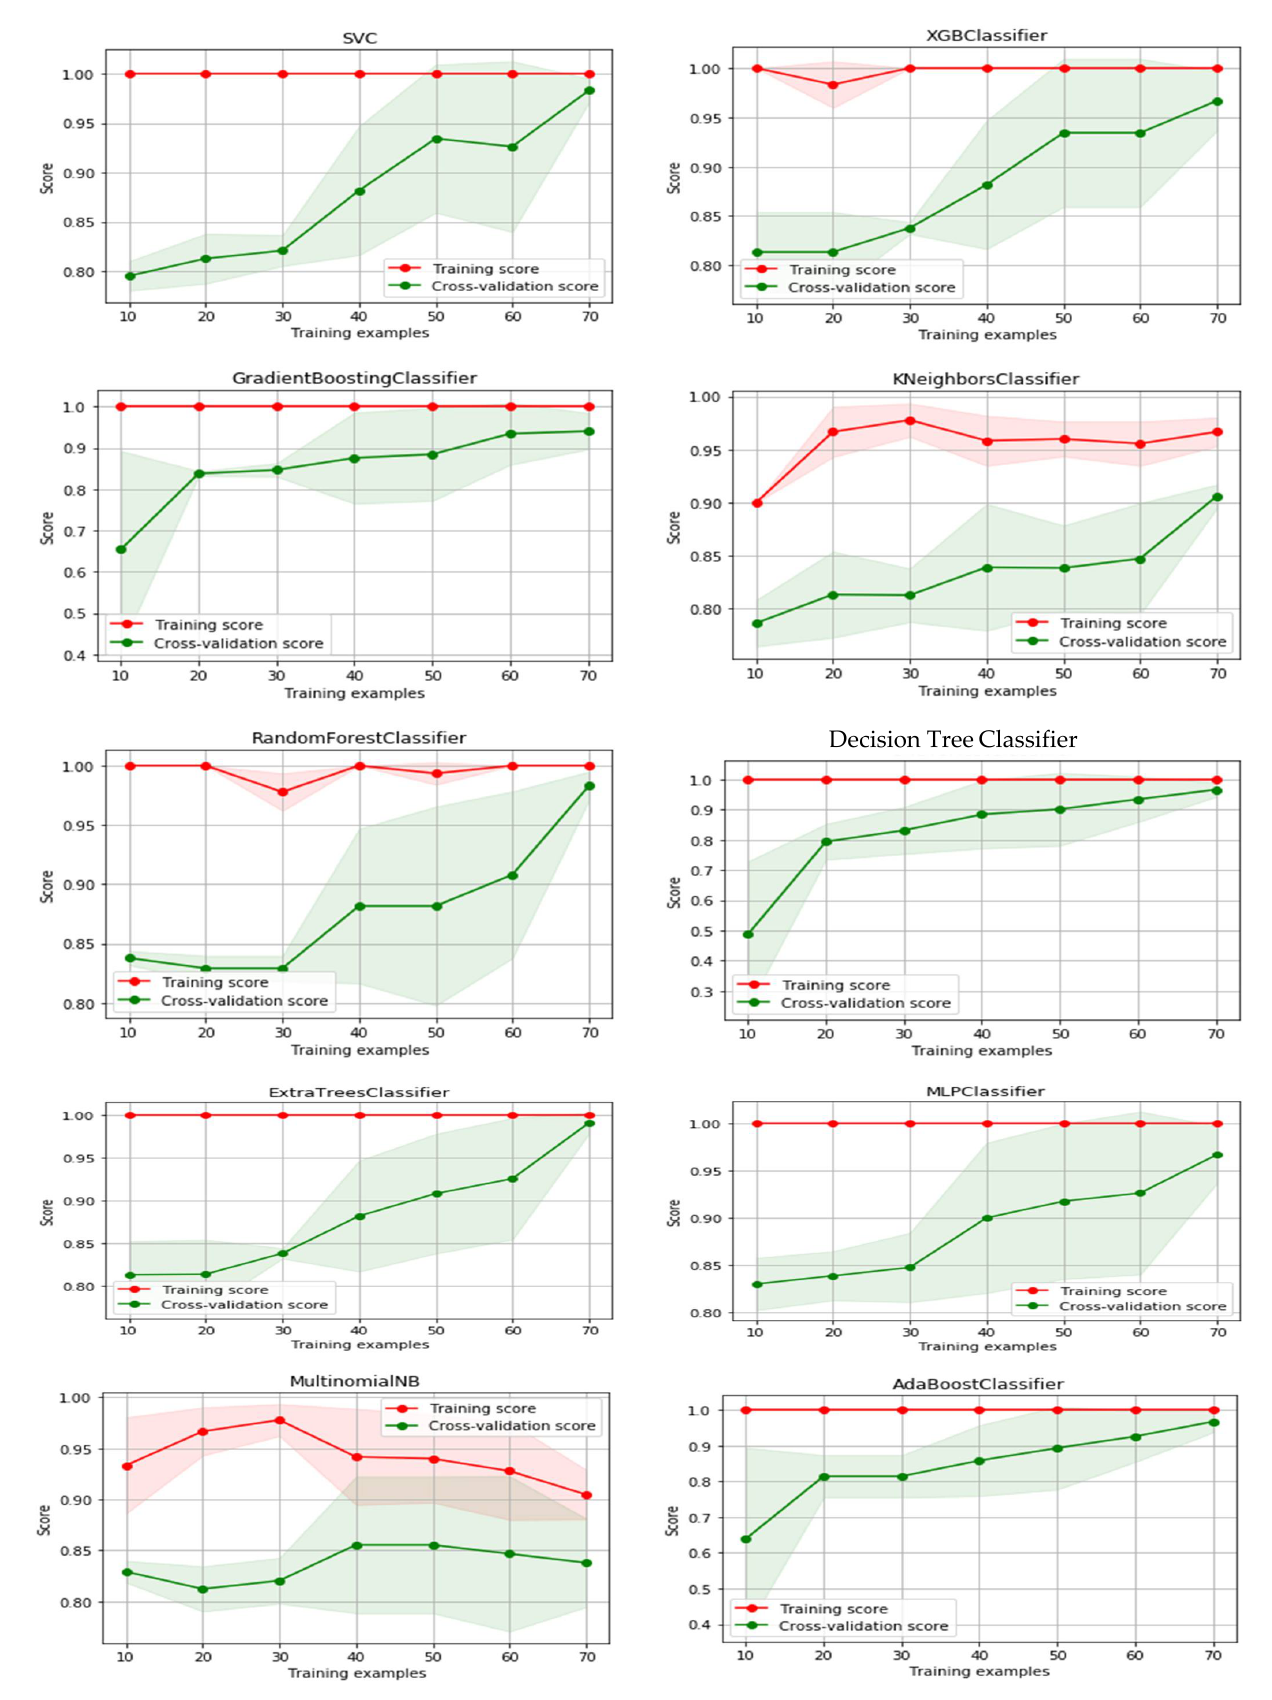
Figure 6. Learning curve based on different percentages of training data for all MLAs. Other metrics used in this study were sensitivity, specificity, and precision.